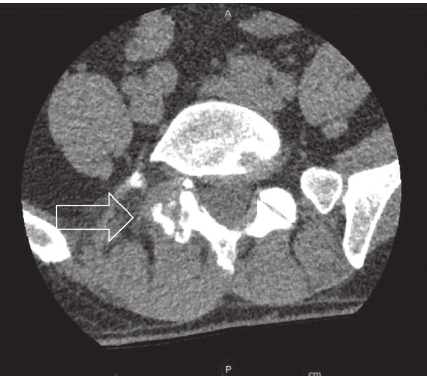
Figure 3: CT of the lumbar spine showing erosive degenerative changes of the right L5-S1 facet joint (arrow), with mild soft tissue prominence surrounding this region. Narrowing of the right L5-S1 neural foramina is also appreciated.